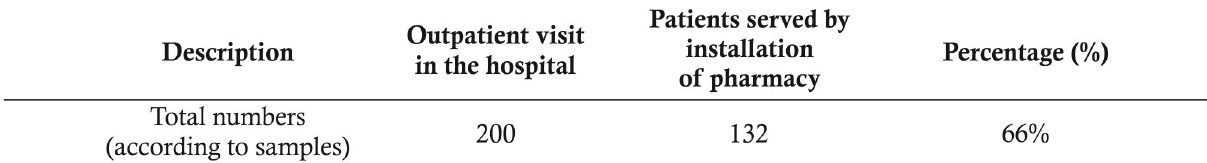
Performance Appraisal in Pharmacy Department Sultan Agung Islamic Hospital by Balanced Scorecard ...